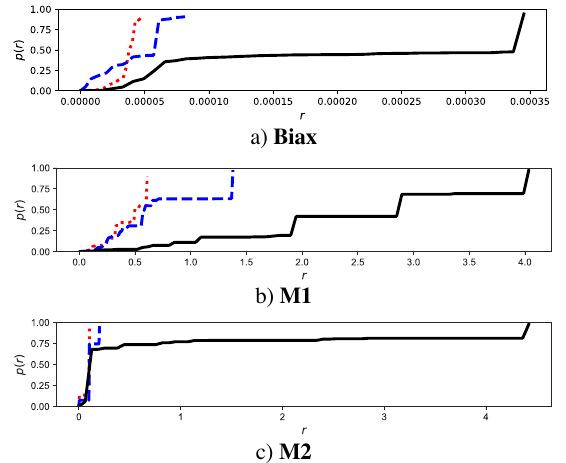
Fig. 5. The order parameter 𝑝(𝑟) 𝑣𝑠.𝑟 profiles at different strain or time states: 𝑡 $ (red dotted line), 𝑡 ∗ (blue dashed line), and 𝑡 # (black solid